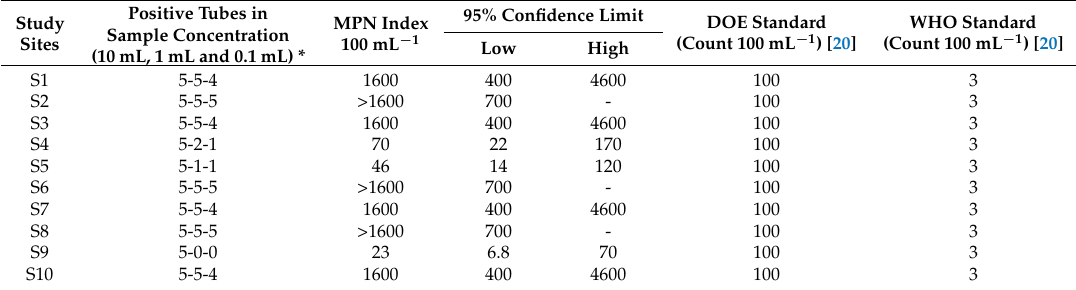
Table 2. The most probable number (MPN 100 mL − 1 ) table for (5 tubes methods) presumptive test analysis of the total coliform bacteria in 10 rivers in Bintulu, Sarawak, Borneo. Study Sites